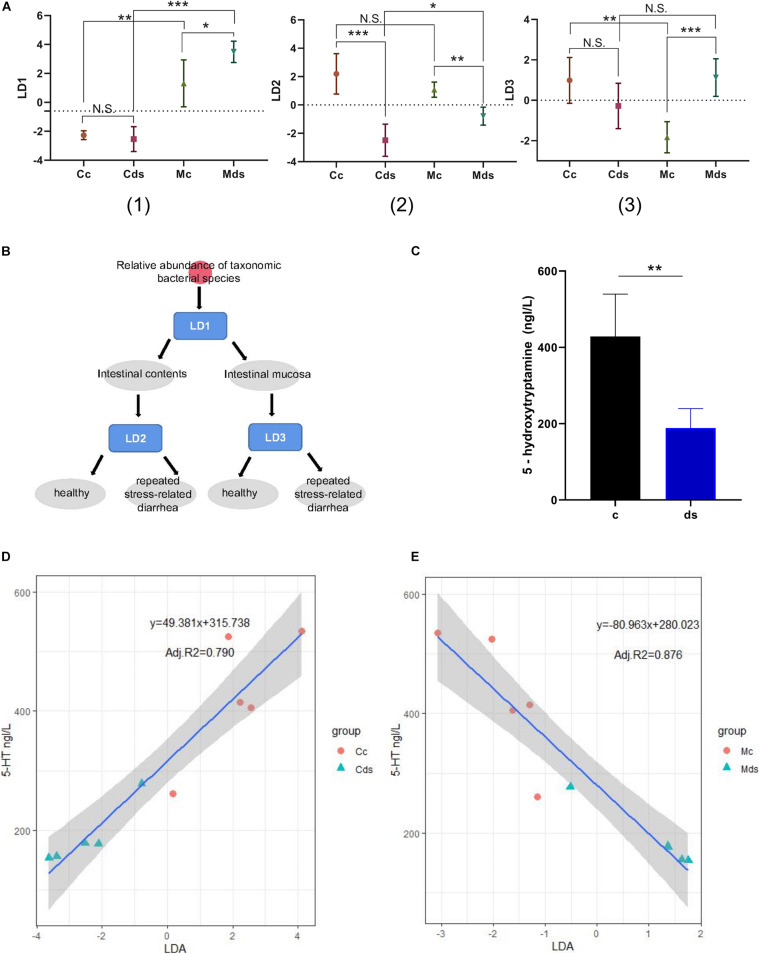
Establishment of a prediction model of 5-HT concentration based on bacterial relative abundance. (A) Prediction and classification of samples by the relative abundance of microbiota-based machine-learning models LD1 (1), LD2 (2), and LD3 (3). (B) Schematic diagram of the bacterial relative abundance model discrimination. (C) Serum 5-HT concentration. (D) Correlation between serum 5-HT concentration and intestinal content microbiota. (E) Correlation between serum 5-HT concentration and intestinal mucosa microbiota. *P < 0.05, **P < 0.01, ***P < 0.001; N.S., not significant (P > 0.05). Cc, intestinal contents in control mice; Cds, intestinal contents in repeated stress-related diarrhea mice; Mc, intestinal mucosa in control mice; Mds, intestinal mucosa in repeated stress-related diarrhea mice.